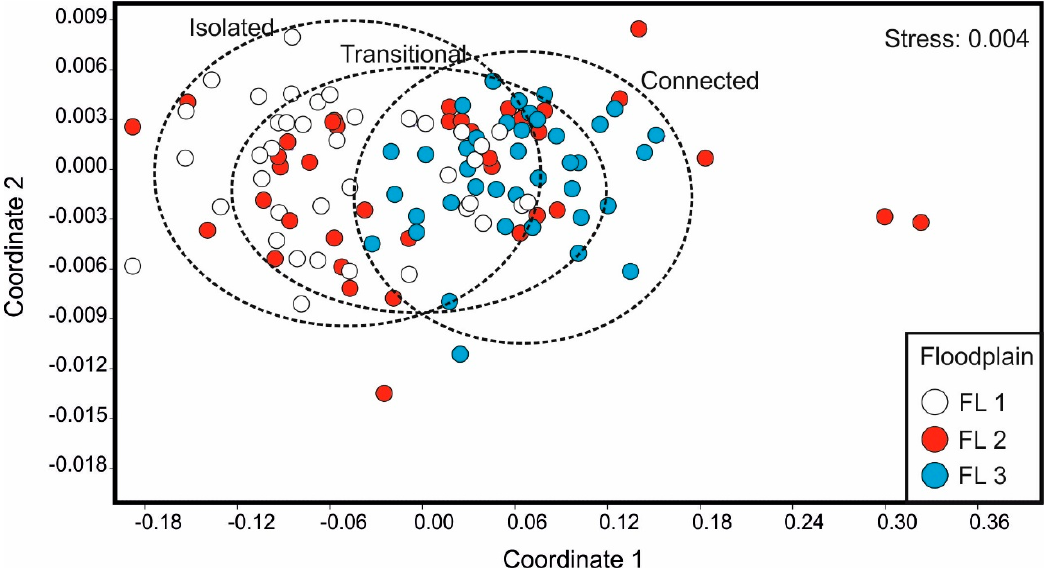
Figure 3. Non ‐ metric multidimensional scaling analysis (nMDS) of the environmental conditions (Secchi disk visibility (SD), temperature (T W ), dissolved oxygen (DO), conductivity (EC) and pH) (Stress: 0.004) in three types of floodplain lakes (FL1—isolated; FL2—transitional; FL3—connected).